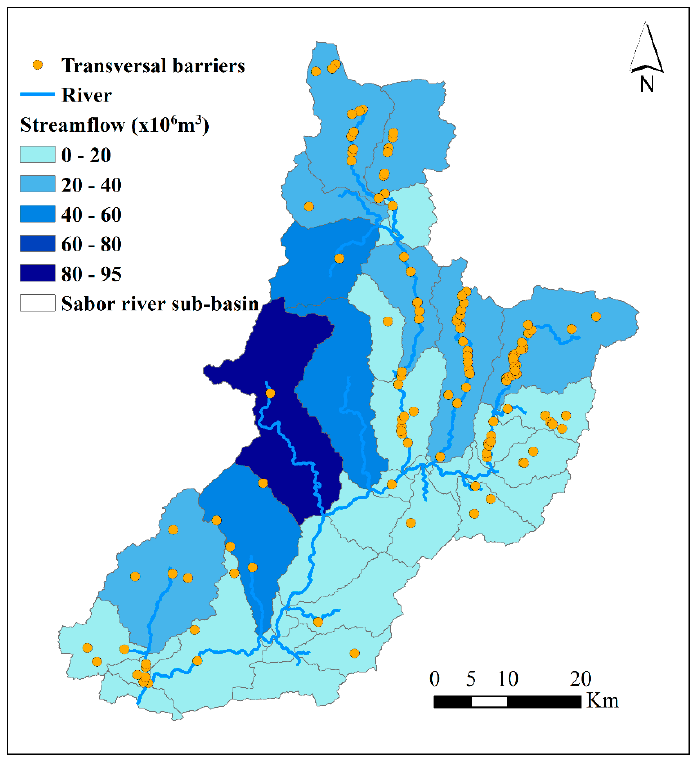
Figure 10. The spatial distribution of dams and weirs in the Sabor River basin and the annual average streamflow between 1960 and 2008.